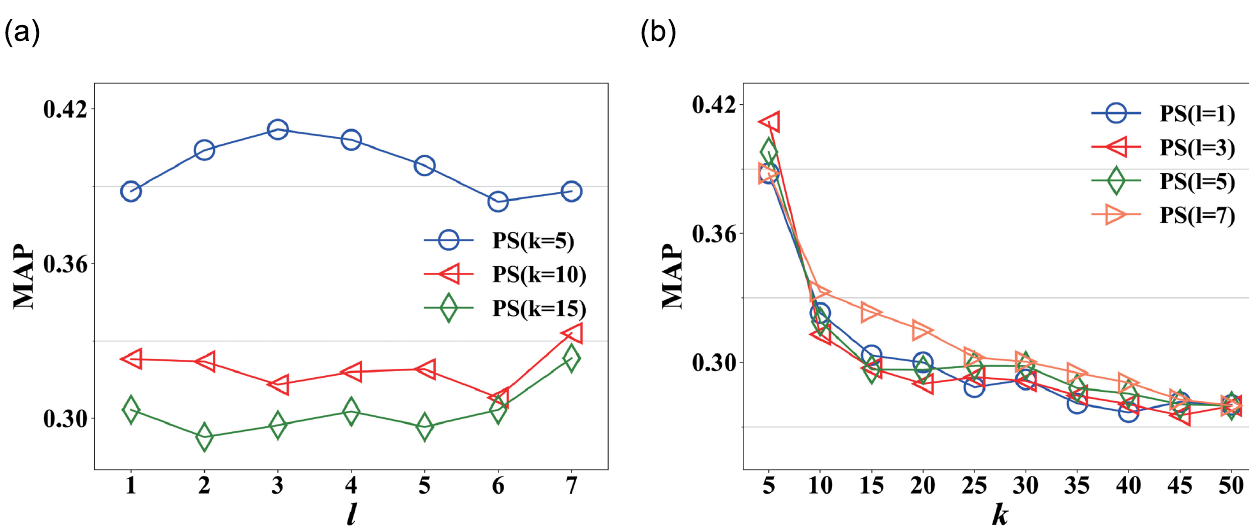
Fig 6. MAP on varying l and k respectively in ImageNet. (a) MAP on varying l , (b) MAP on varying k .